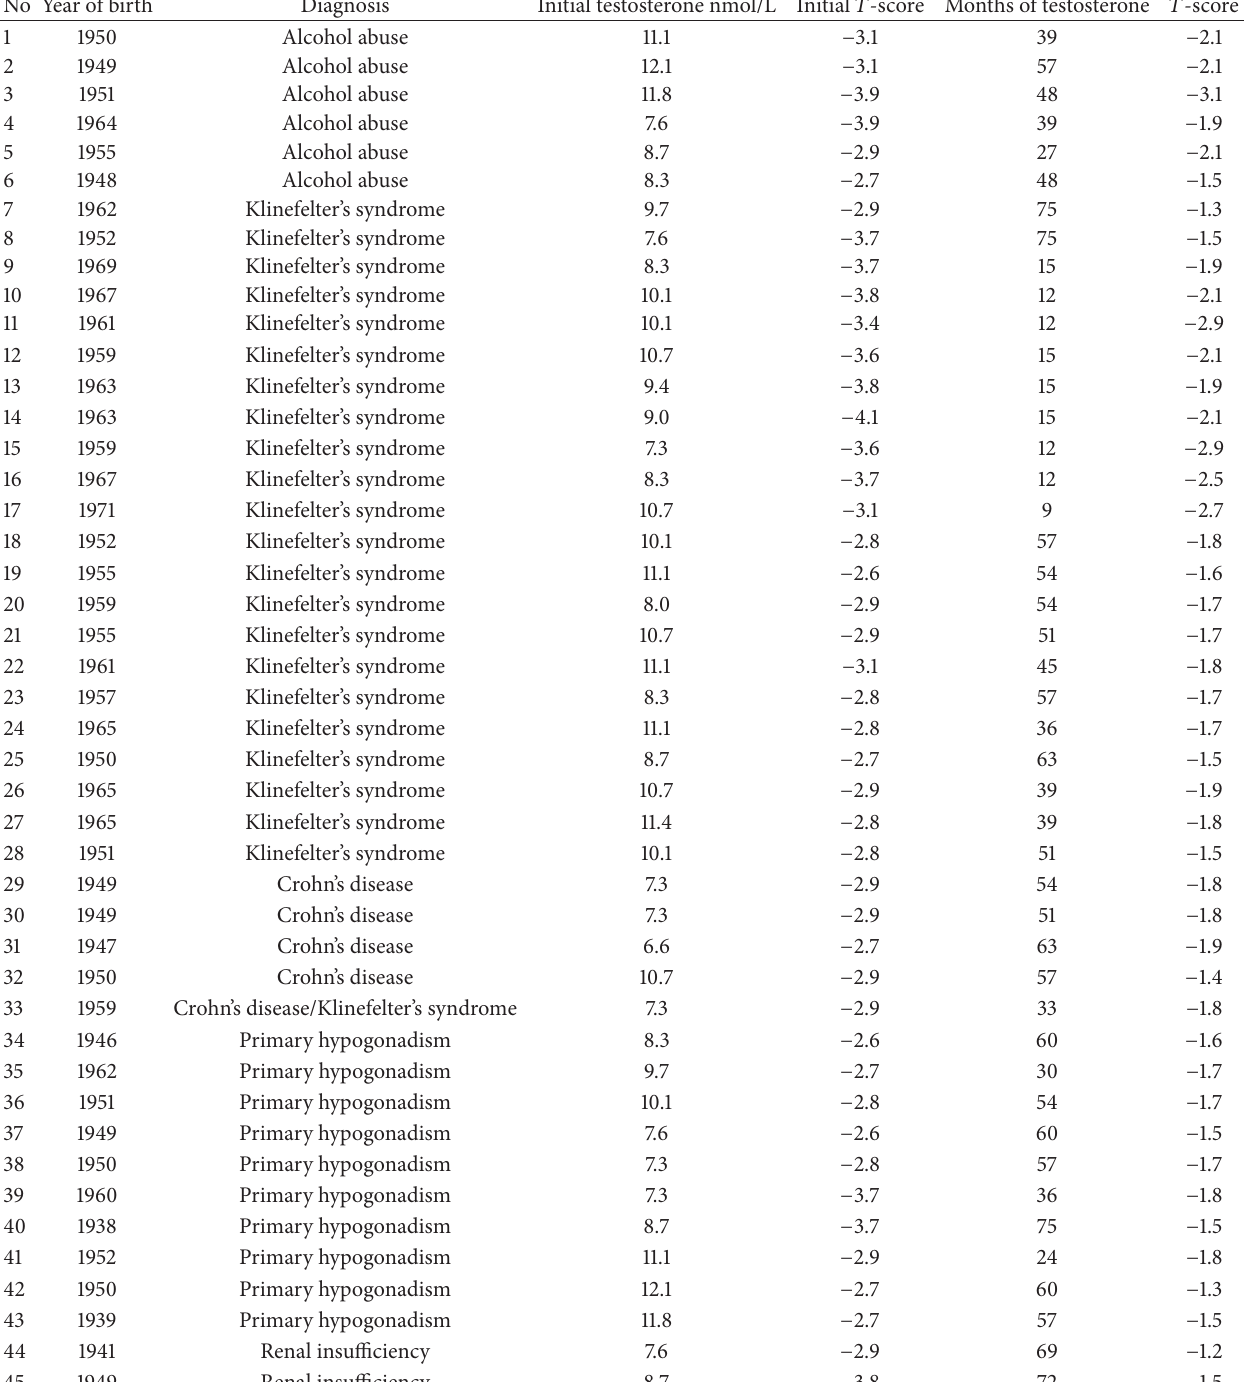
Table 1: Patient characteristics and gains in 𝑇 -score upon testosterone